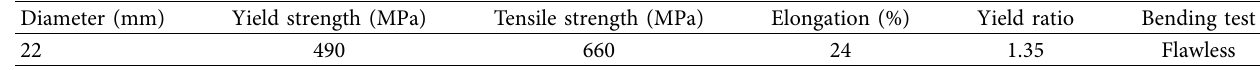
Table 3: Material properties of longitudinal reinforcement.